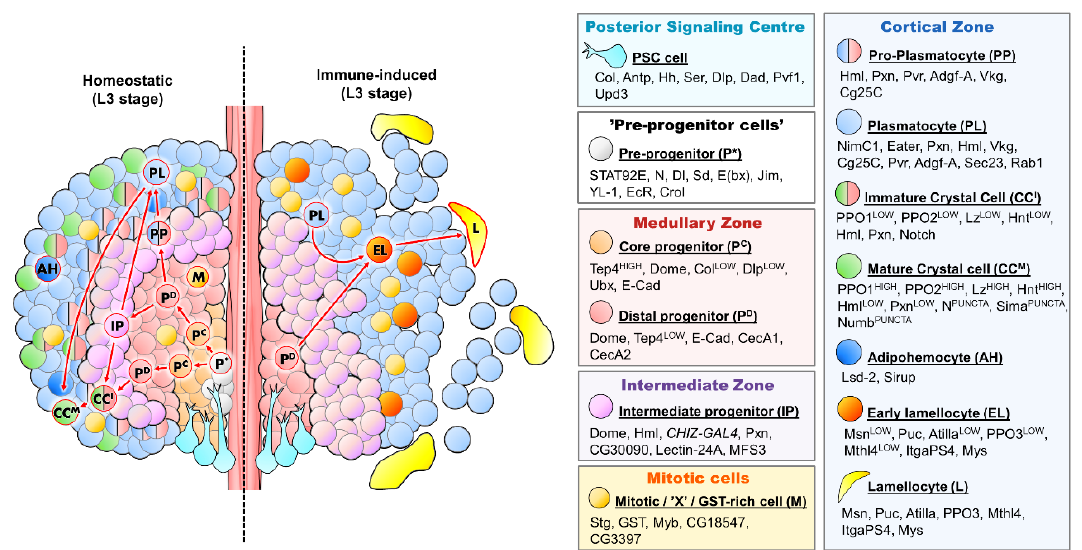
Figure 1. The main functional zones and cell types of the Drosophila lymph gland. The primary lobe of a third instar larva is shown under homeostatic conditions ( left half) and following immune induction ( right half). The different hemocyte lineages are indicated with red arrows. The individual cell types shown on the figure are defined on the right panels, along with their respective marker molecules and the zones they reside in.